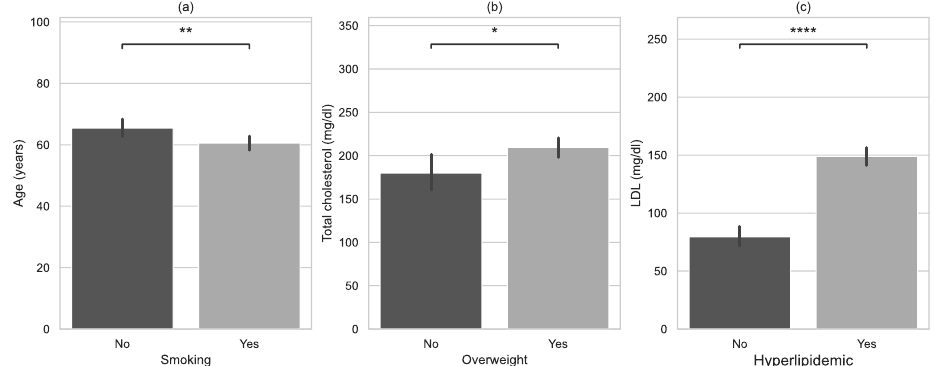
Figure 2. Characteristics of examined groups with error bars and p -value annotation legends: ( a ) age vs. smoking, ( b ) total cholesterol vs. overweight, ( c ) LDL vs. hyperlipidaemia. *: 0.01 < p ≤ 0.05; **: 0.001 < p ≤ 0.01; ****: p ≤ 0.0001.